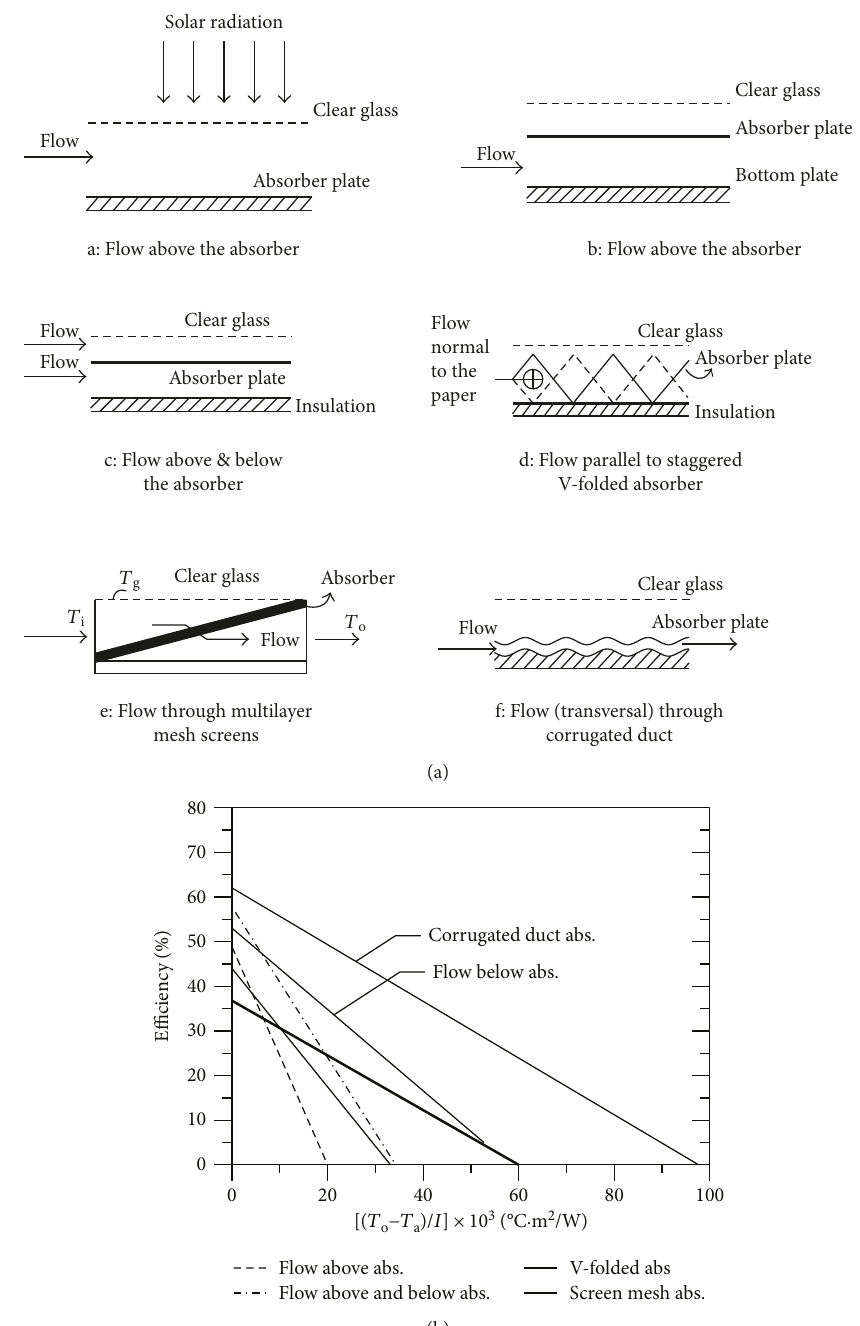
Figure 2: (a) Di ff erent solar air collector con fi gurations [27]; (b) thermal e ffi ciency and reduced temperature relationship for the tested collectors